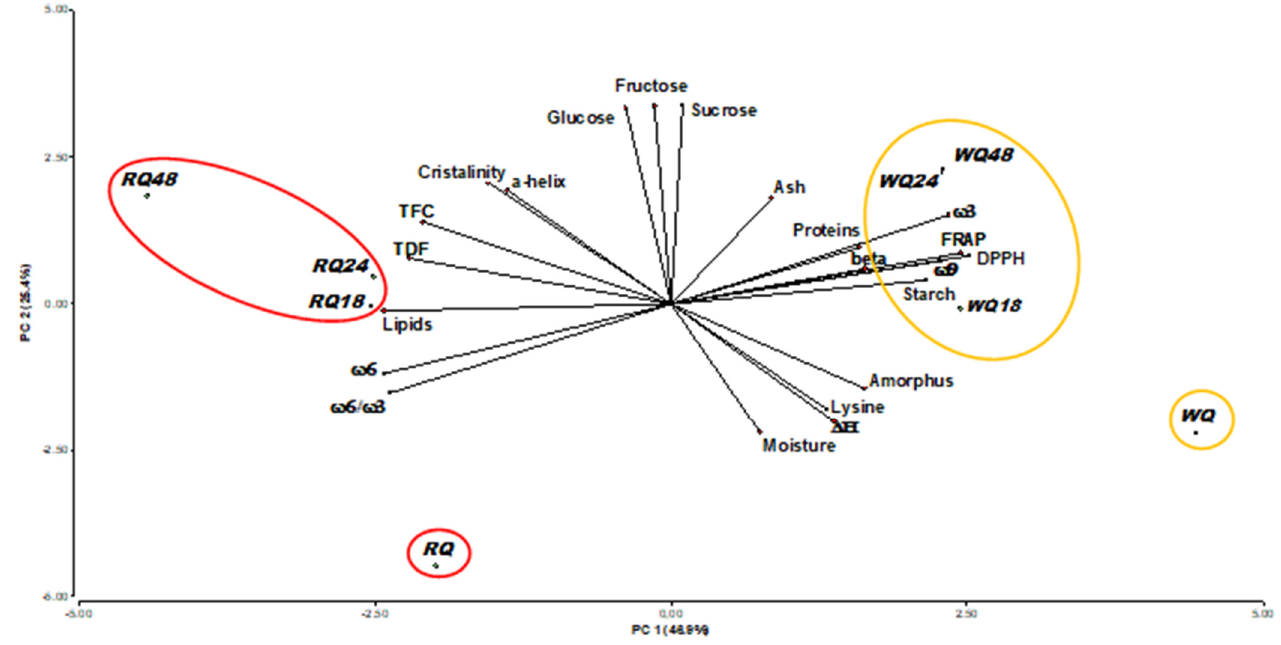
Figure 4. Biplot (PCA) of the correlation between quinoa varieties and quinoa germination. In the case of red quinoa, 24 h of germination (RQG24) resulted in flour with 13% more of lipids and 7% more of total dietary fiber (TDF), in comparison to the ungerminated red quinoa. After germination, protein underwent structural changes with higher unfolding and starch presented a lower proportion of amorphous region, both evidenced by